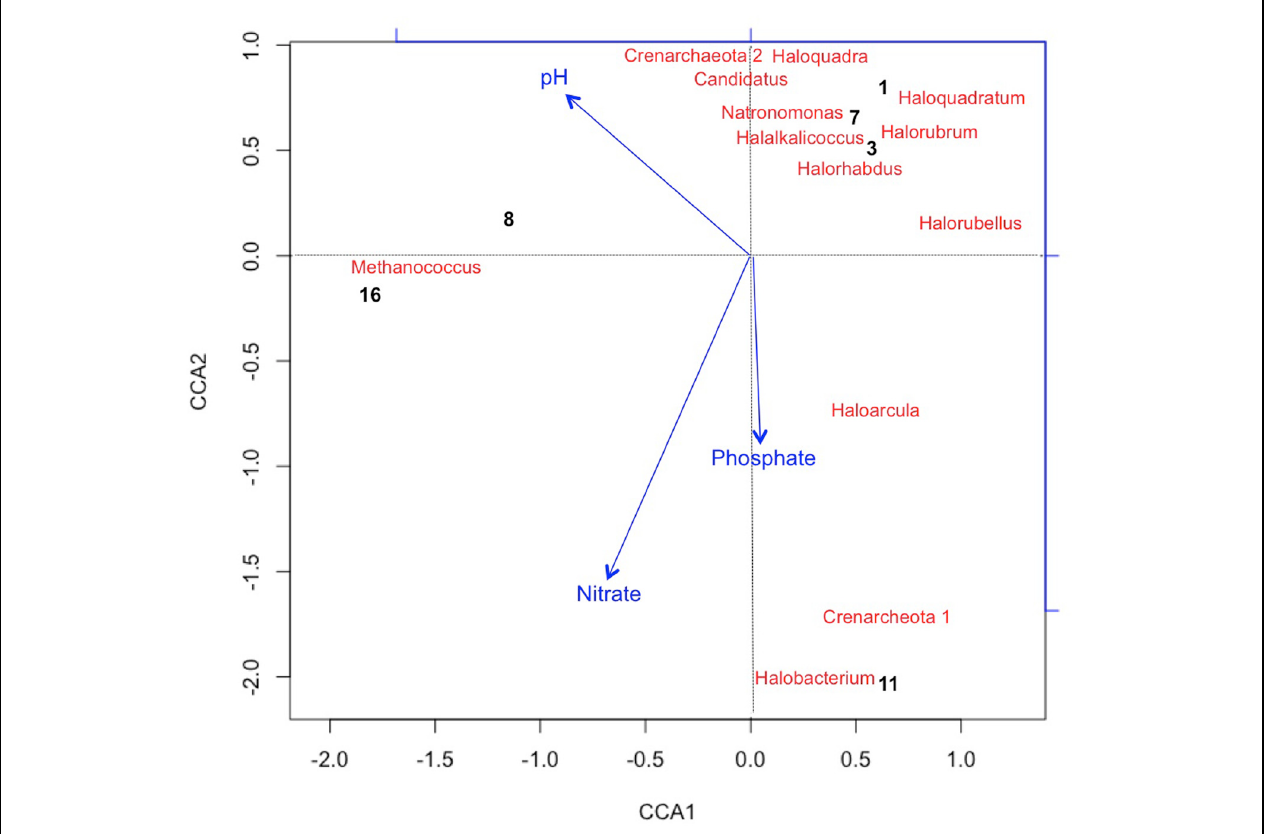
FIGURE 4 | Canonical Correspondence Analysis (CCA) plotting chemical variables that correlated with variation in Archaeal taxa (with > 2% relative abundance) and sample points. Archaea generally lacked long term survivability in the pond. CCA1 = 81.8% and CCA2 =